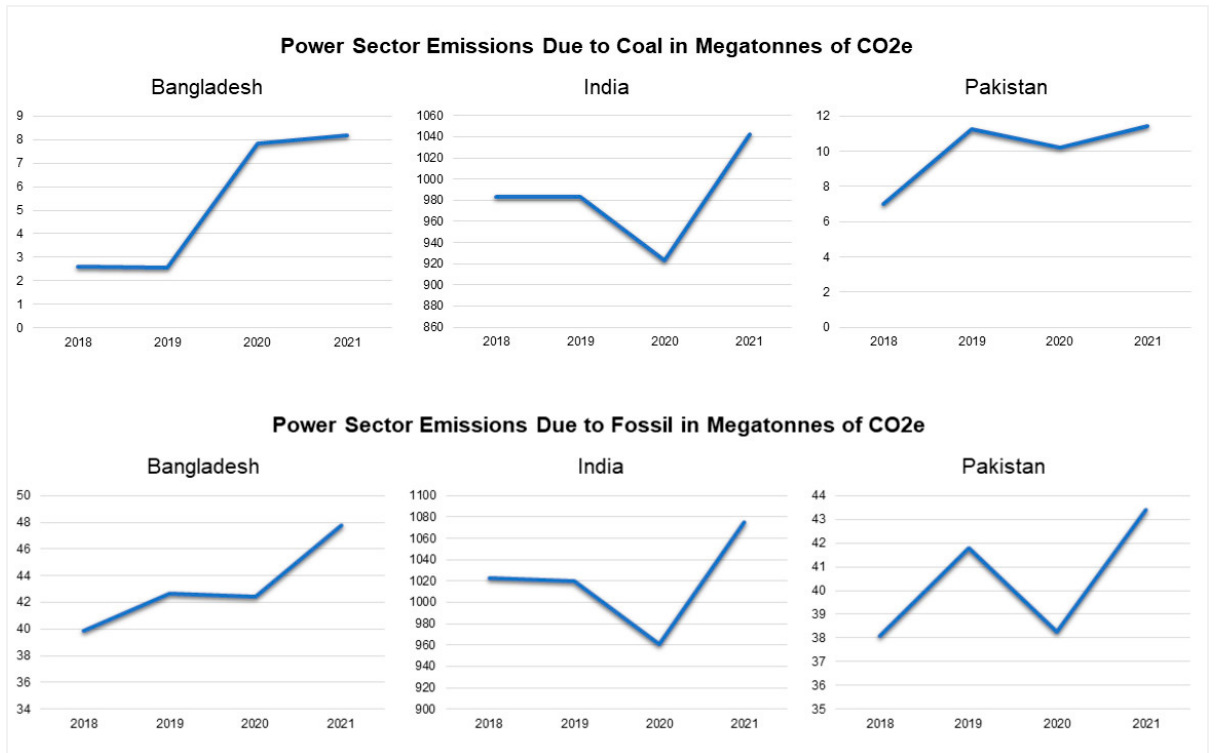
Figure 1. Power sector emissions as a consequence of coal and fossil use in megatons of CO 2 (2018–2021) [43].